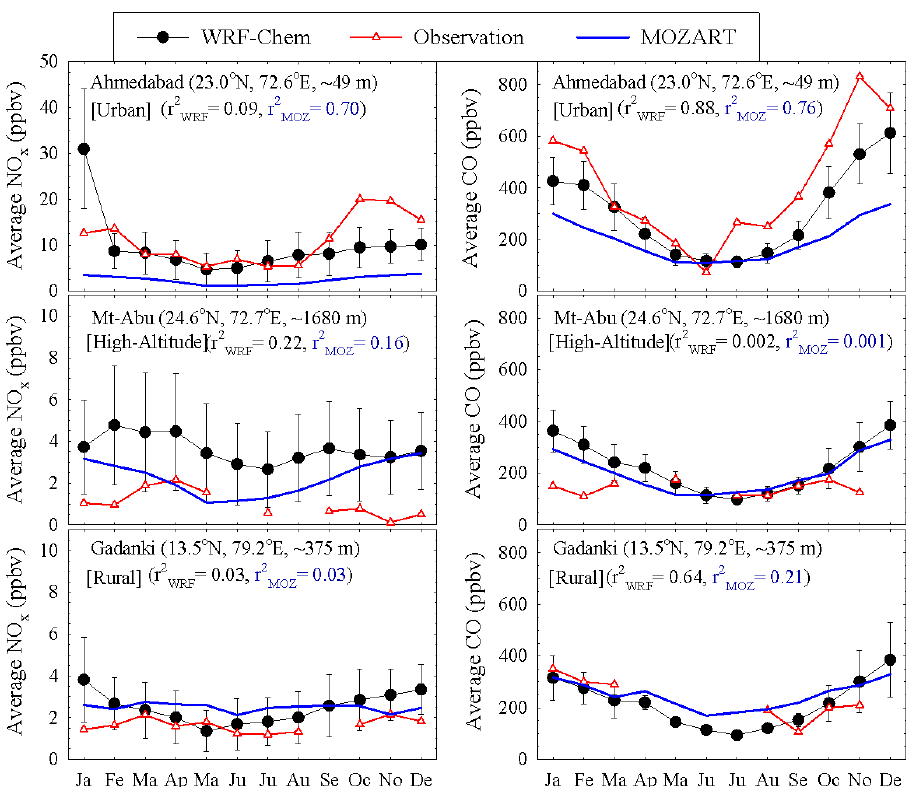
Fig. 5. Comparison of the observed and WRF-Chem simulated seasonal variations in average surface NO x (left panel) and CO (right panel) at three sites located within the Indian region. Note the scales vary among the sites and that the observations are not representative of the year 2008. The standard deviations in monthly average CO levels at these sites are generally 50–200ppbv and those in NO x levels are generally 1–6ppbv. r 2 and r 2 represent the correlation coefficient of WRF-Chem and MOZART with observations, WRF MOZ